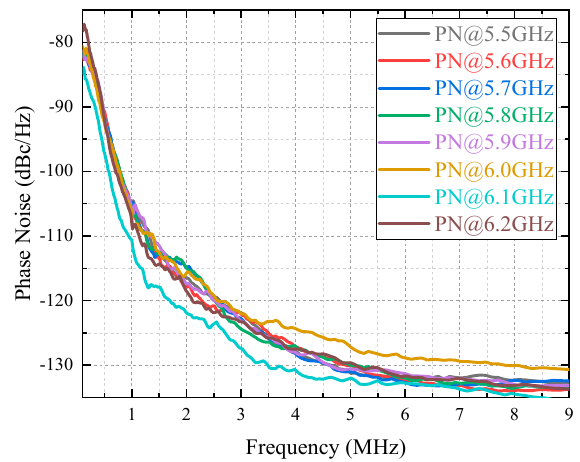
Figure 12. Measured phase noise of the PLL at different frequency locked.